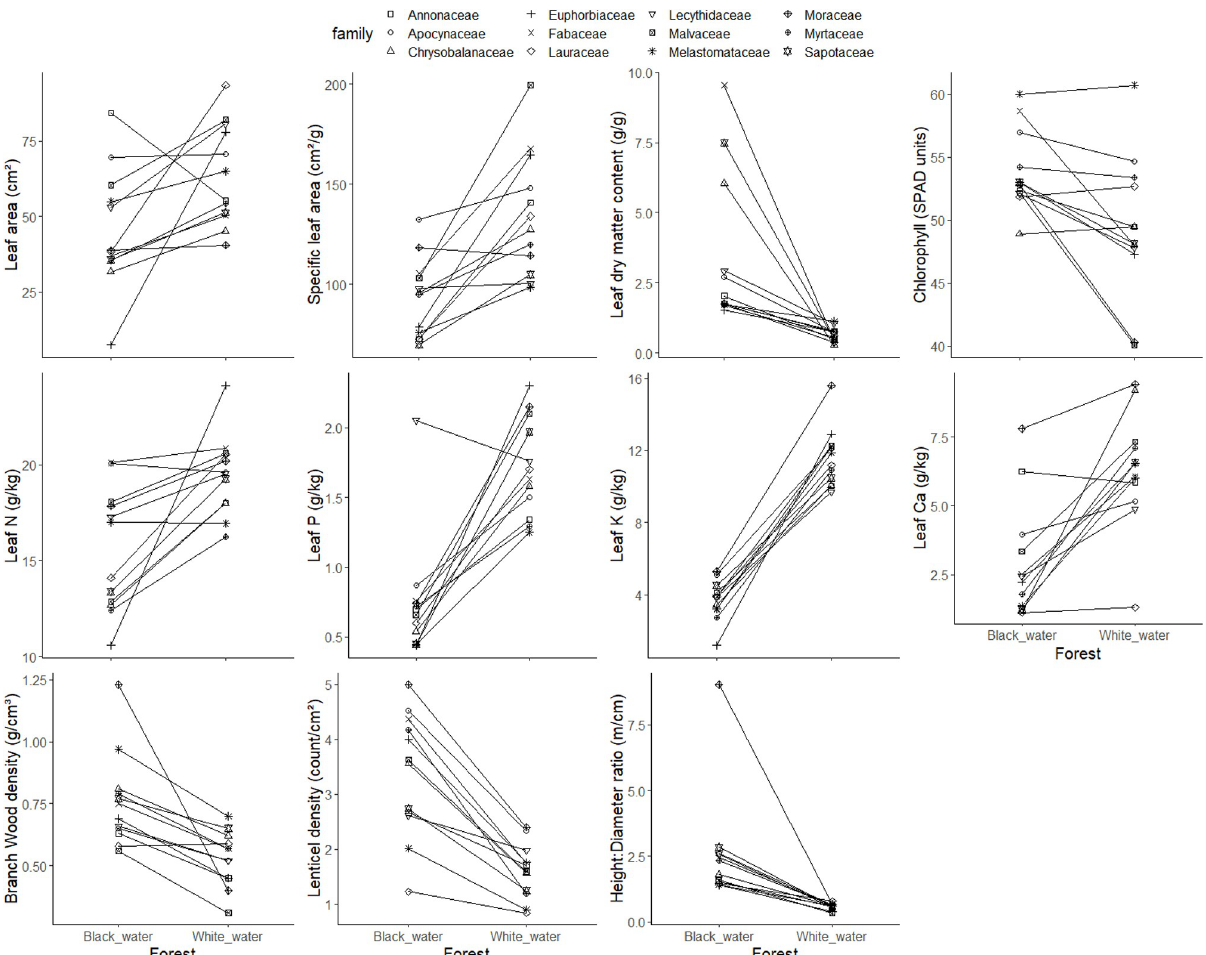
Fig 2. Mean values of leaf area, specific leaf area, leaf dry matter content, leaf chlorophyll, leaf nitrogen (N), leaf phosphorus (P), leaf potassium (K), leaf calcium (Ca), branch-wood density, lenticel density and height:diameter ratio for twelve pairs of families of white-water and black-water forests. Lines connect the family pairs. Mean values are based on 5 individuals per family and forest